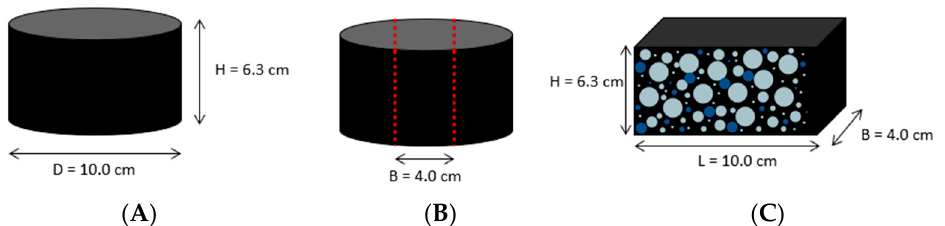
Figure 3. Specimen preparation for the measurements with the imaging techniques (( A ) = specimen; ( B ) = cut area for preparation; ( C ) = cut specimen).